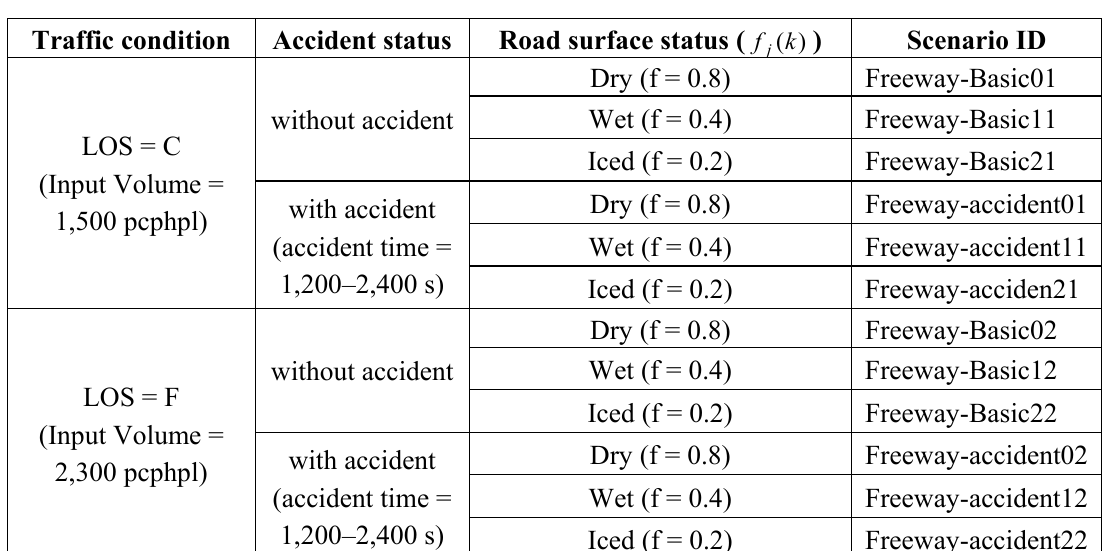
Table 3. Simulation